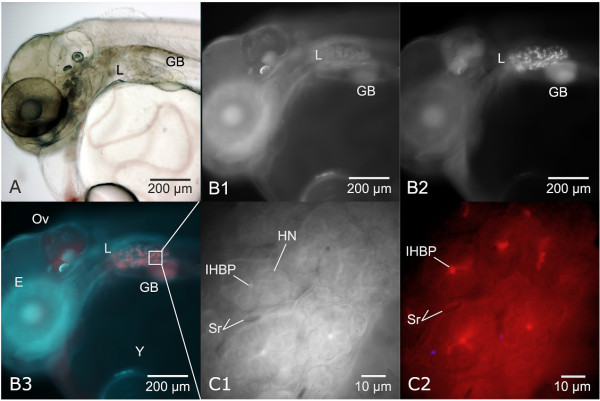
In vivo imaging of hepatobiliary metabolism, transport, and hepatic morphology. Utilizing endogenous tissue autofluorescence in tandem with exogenous fluorescent probes allowed in vivo elucidation of biological structure and function. Illustrated is the in vivo application of 7-benzyloxyresorufin (7BR) for detection of CYP3A metabolic activity. Dechorionated embryos exposed (aqueous bath) to the CYP3A substrate 7BR exhibited 7-benzyloxyresorufin-O-dealkylation (BROD) activity, which resulted in the generation of the fluorescent metabolite resorufin (red). All in vivo images from an individual STII medaka, 6 dpf. (A) Brightfield microscopy, showing liver (L) and gall bladder (GB). (B1) Same animal as in frame A, imaged with widefield fluorescence microscopy (DAPI/UV excitation) illustrating tissue autofluorescence. (B2) Widefield fluorescence (TRITC) image capture of resorufin (indicative of CYP3A metabolic activity) fluorescence in the intrahepatic biliary passageways of the embryonic liver. Resorufin fluorescence is distinct and limited to the intrahepatic biliary passageways of the liver (L) and gall bladder (GB). (B3) Color composite of B1 and B2, DAPI/TRITC image captures, illustrating resorufin fluorescence (red) in the liver (L) and gall bladder (GB). (C1 and C2) In vivo imaging of region of interest in frame B3 (white square) showing in vivo phenotype of hepatic parenchyma at 6 dpf. Six to 8 hepatocytes were observed (in transverse section) to surround a central bile passageway (IHBP) at their apical membranes. C2 illustrates concentrative transport of resorufin from hepatocellular cytosol to intrahepatic biliary passageways (IHBPs), indicated by increased fluorescence in the tubule lumen, or intrahepatic biliary passageway. Red blood cells were observed actively circulating through hepatic sinusoids (S/r). Hepatocyte nuclei (HN).